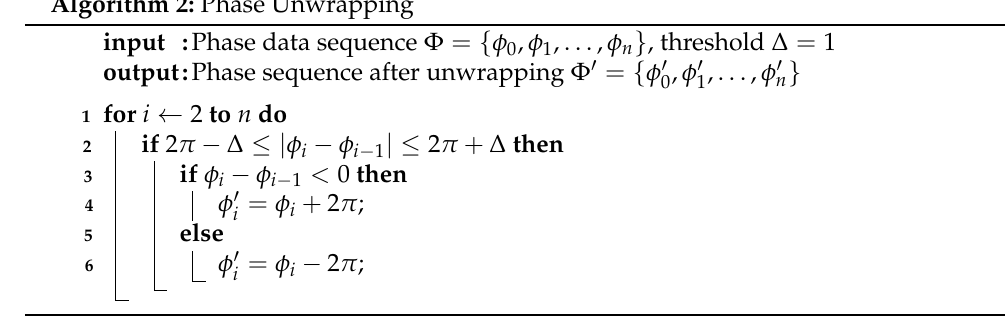
Algorithm 2: Phase